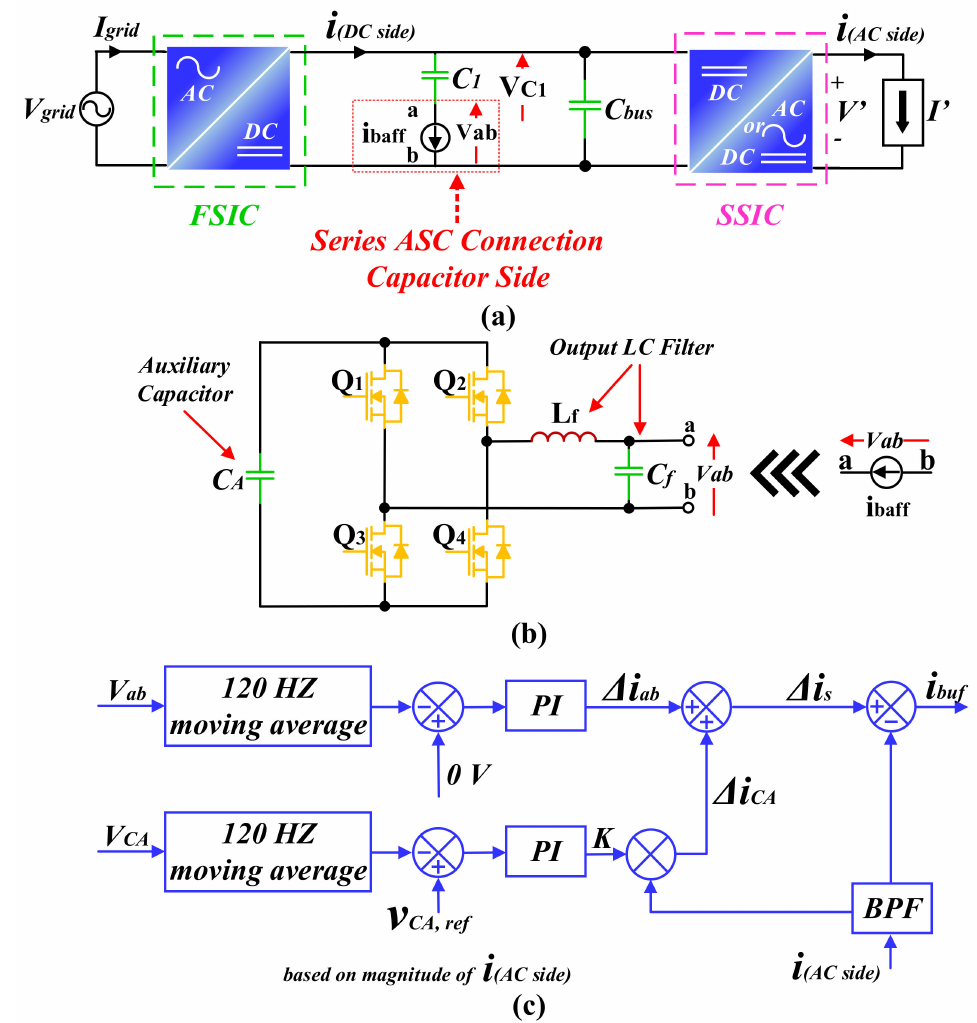
Figure 13. ( a ) Generalized two-stage, grid-connected power conversion system with inserted ASC unit series connection based at the capacitor side; ( b ) series connection ASC circuit; ( c ) controlled current source strategy for series connection